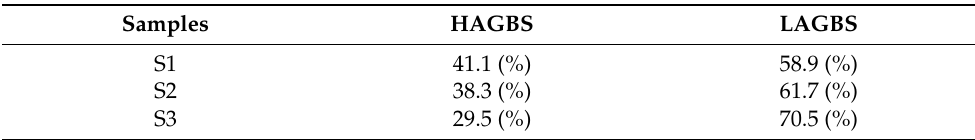
Table 4. The relative frequency of the HAGBs and LAGBs of an X80 × D1422 mm heavy-wall heat-induced seamless